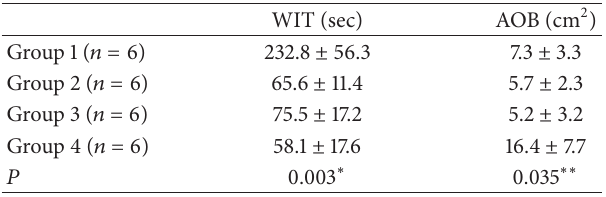
Table 1: Comparison of warm ischemia time (WIT) and amount of bleeding (AOB) in study